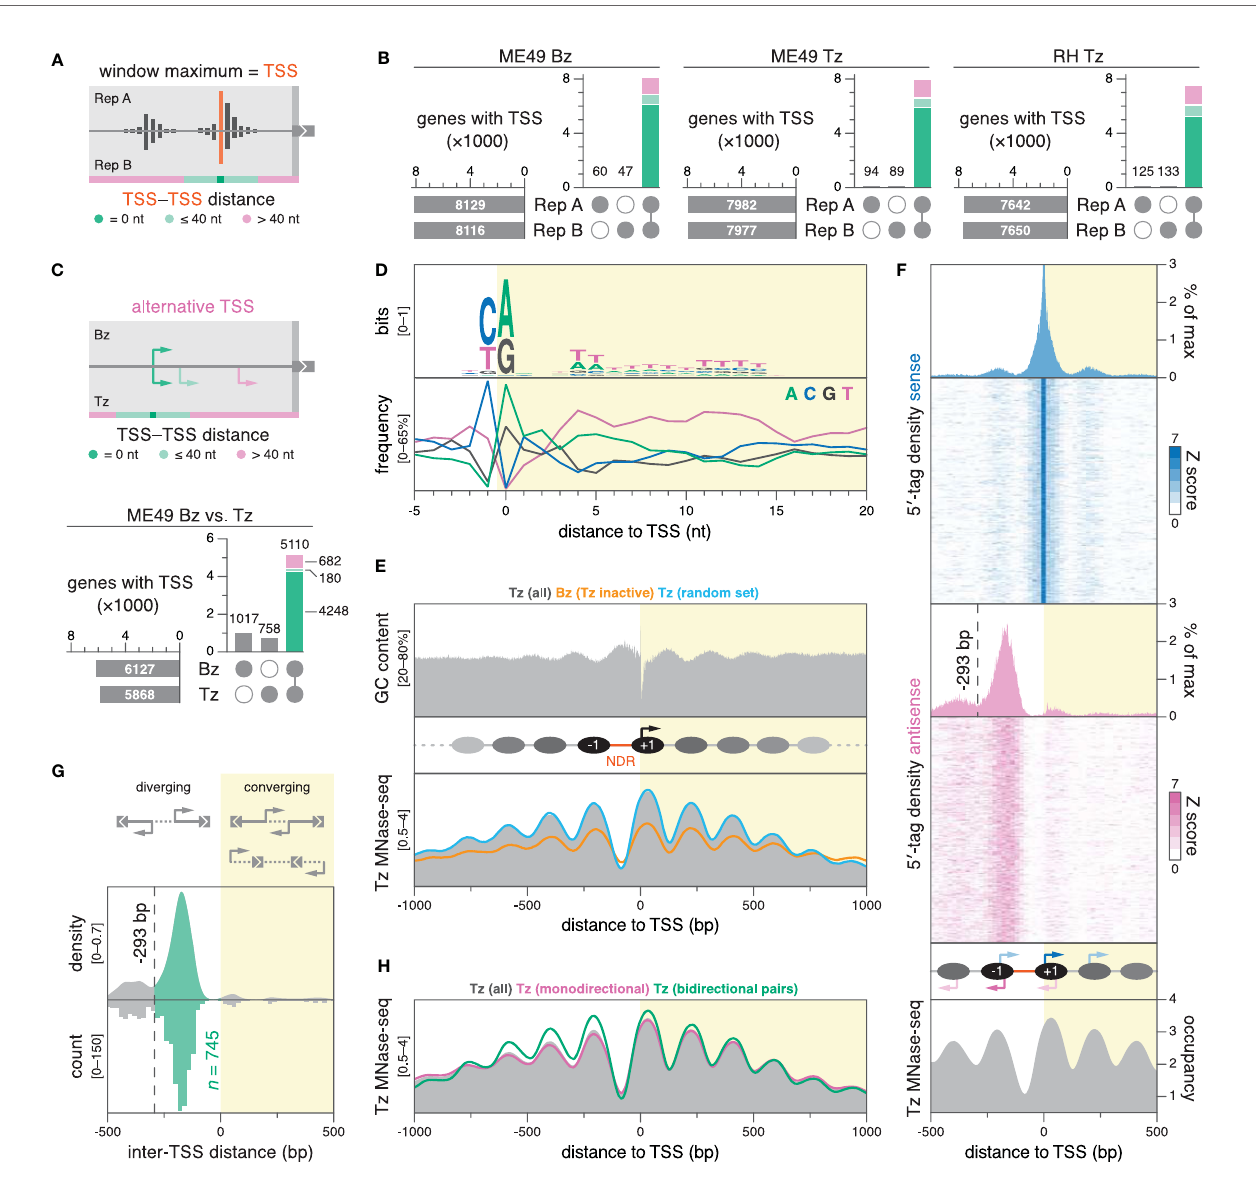
FIGURE 3 | DNA sequence and nucleosome positioning are strong determinants of transcription initiation in Toxoplasma . (A) Strategy for TSS mapping. We de fi ned the TSS as the nucleotide position with the maximal 5 ′ -tag count within a gene-association window. High-con fi dence TSSs were selected by assessing their reproducibility across biological replicates. TSSs separated by 40 nt or less were considered to be within the same cluster. (B) UpSet plots showing the intersection of TSSs between biological replicates, colored by inter-TSS distance. Only TSSs that replicate at the exact nucleotide position are considered for subsequent plots. (C) Differential TSS usage between ME49 Bz and Tz was similarly evaluated, clustering TSSs separated by less than 40 nt. UpSet plot shows the intersection of nucleotide-matching Bz and Tz TSSs, colored by inter-TSS distance. (D) Nucleotide composition around ME49 Tz TSSs; n = 5866. (E) GC content around ME49 Tz TSSs (top) and nucleosome occupancy around different subsets of ME49 TSSs (bottom). Nucleosome occupancy was determined by MNase-seq on Tz of the Toxoplasma Pru strain (Farhat et al., 2020). Nucleosome occupancy in Tz around the set of unique Bz TSSs (orange; n = 1017) or a randomly-sampled subset of Tz TSSs of equal size (blue). (F) Periodicity of secondary and antisense transcription initiation corresponds to nucleosome positioning. Sense (blue) and antisense (magenta) 5 ′ -tag counts displayed as densities or stacked values, above nucleosome occupancy (gray). 5 ′ -tag counts were normalized to the sense maximum before collapsing into density plots. Stacked values represent 5 ′ -tag counts normalized strand-speci fi cally to the maximum intensity of each locus along 20-nt bins. As the proportion of sense 5 ′ -tag counts amounts to ~95% at position 0, the histogram is cropped to visualize minor density patterns. The dotted line marks a local minimum in antisense 5 ′ -tag density at -293 bp, which subsequently served as a distance threshold for de fi ning diverging gene pairs as bidirectional. (G) Density plot (bandwidth = 20) and histogram (binwidth = 20 bp) of the distance between TSSs of adjacent gene pairs in ME49 Tz. Negative distances correspond to diverging (head-to-head) TSSs, while positive values correspond to converging TSSs, which could result in overlapping transcripts. Distances from -293 to 0 bp indicate putative bidirectional gene pairs (green). (H) Nucleosome occupancy around indicated subsets of ME49 Tz